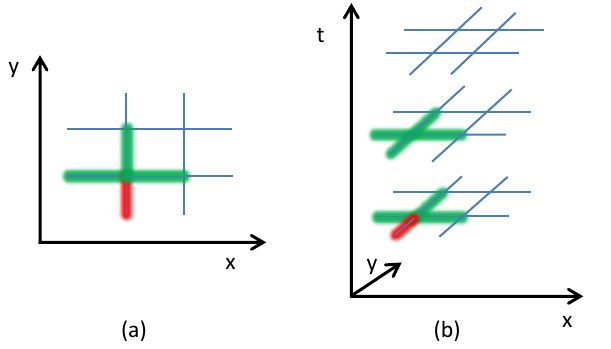
Figure 3. Example of a snake initialized by a link in red. The green links represent the neighborhood, according to a 2D approach ( a ) and a 3D approach ( b )